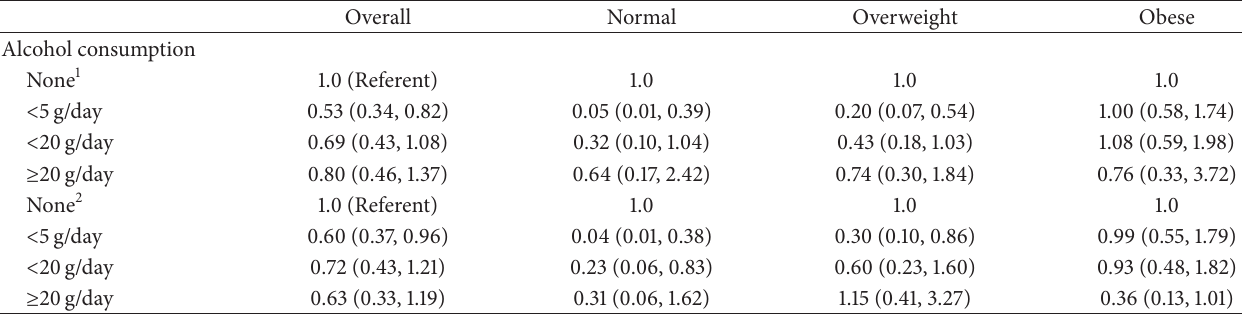
Table 3: Multivariate relative risks (95% confidence interval) for new cases of type 2 diabetes mellitus in employed men and women, 1988– 1990. Overall Normal Overweight Obese Alcohol